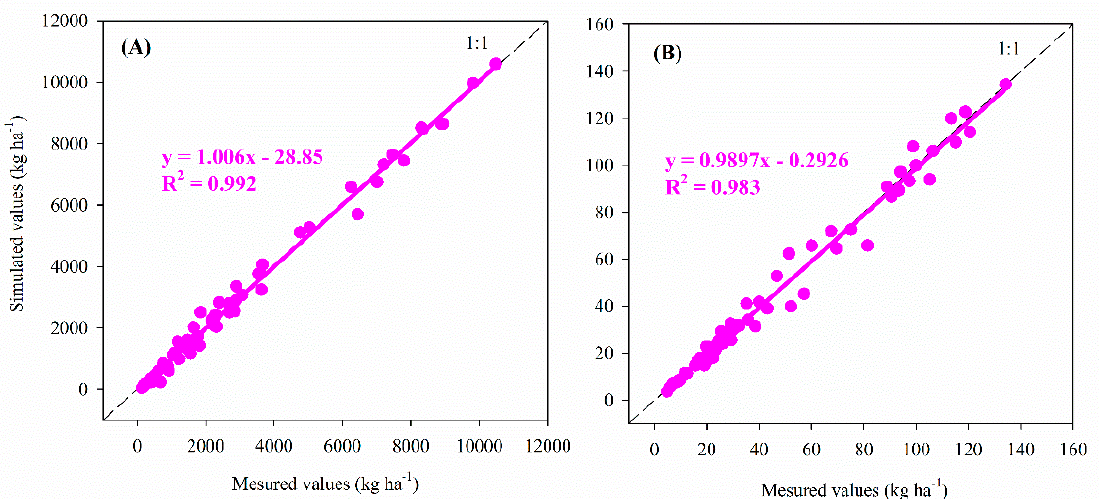
Figure 1. Correlation between the measured and simulated values for ( A ) aboveground biomass and ( B ) N accumulation. Data were pooled from three winter oilseed rape cultivars grown under 0 and 180 kg N ha − 1 supply in the 2014–2015 and 2015–2016 seasons.